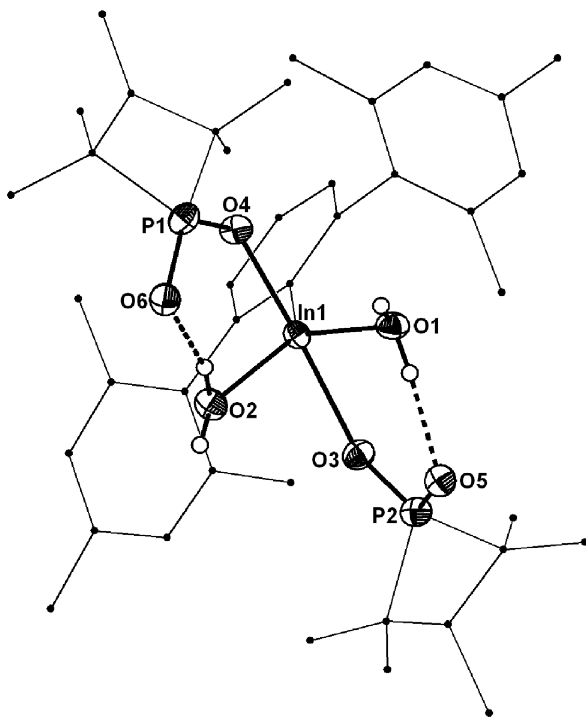
Figure 3 Molecular structure of 3 showing 30% probability ellip- soids and the crystallographic numbering